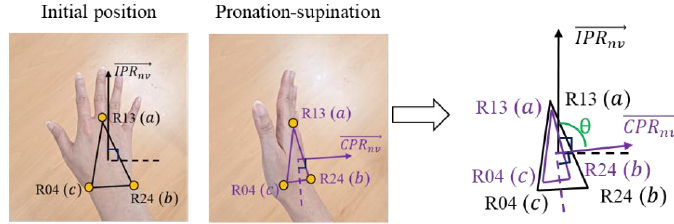
Figure 8. Wrist twist (pronation – supination) angle calculation.